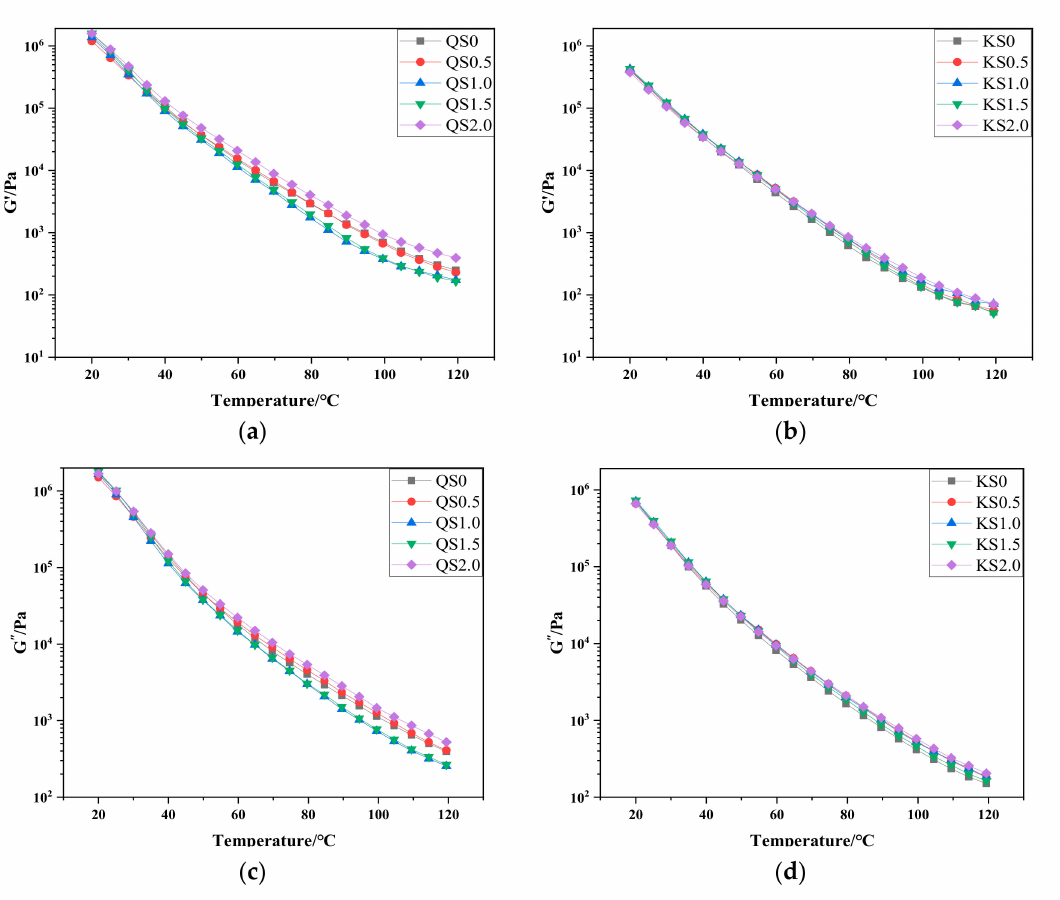
Figure 5. Variation of storage modulus (G’) and loss modulus (G”) of warm mix rubber asphalt with temperature: ( a ) G’ of QS warm mix rubber asphalt; ( b ) G’ of KS warm mix rubber asphalt; ( c ) G” of QS warm mix rubber asphalt; ( d ) G” of KS warm mix rubber asphalt.